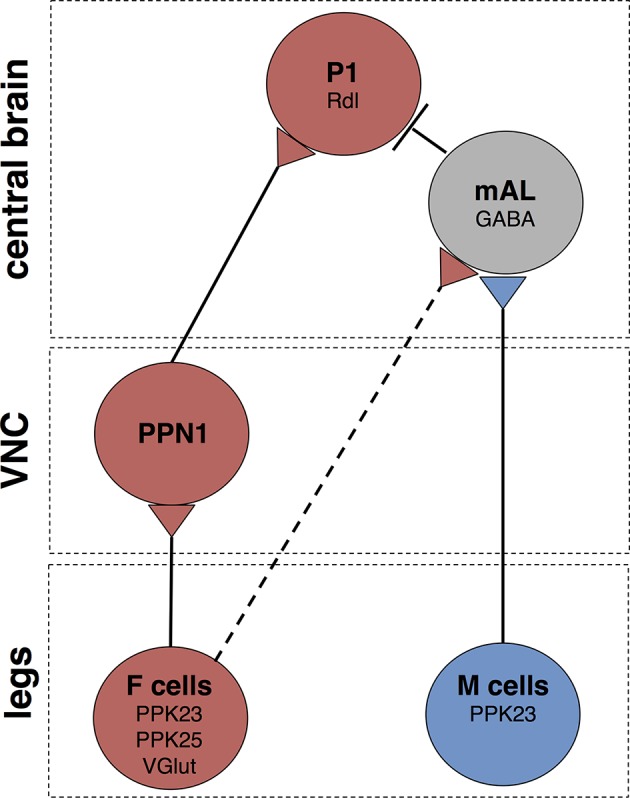
Schematic of courtship-promoting and courtship-inhibiting circuits activated by F and M cells.F cells on the leg express PPK23, PPK25, and VGlut, and respond to female pheromones. M cells on the leg express PPK23 and respond to male pheromones. The M cell neurotransmitter is unknown. F cells activate PPN1, a class of projection neuron with cell bodies and dendrites in the VNC and long-range axonal projections to the ventrolateral protocerebrum. PPN1 axons are in close proximity to P1 fibers, and PPN1 activation causes activation of P1. M cells on the leg activate GABAergic mAL neurons, which connect the SEZ and superior lateral protocerebrum. mAL axons interdigiate with P1 fibers, and mAL acitvation causes hyperpolarization of P1, likely through the GABA-A receptors containing the Rdl subunit. F cells also provide an inhibitory drive onto P1 via mAL. The contact between F cells and mAL is not direct (dotted line). Other connections may not be monosynaptic.